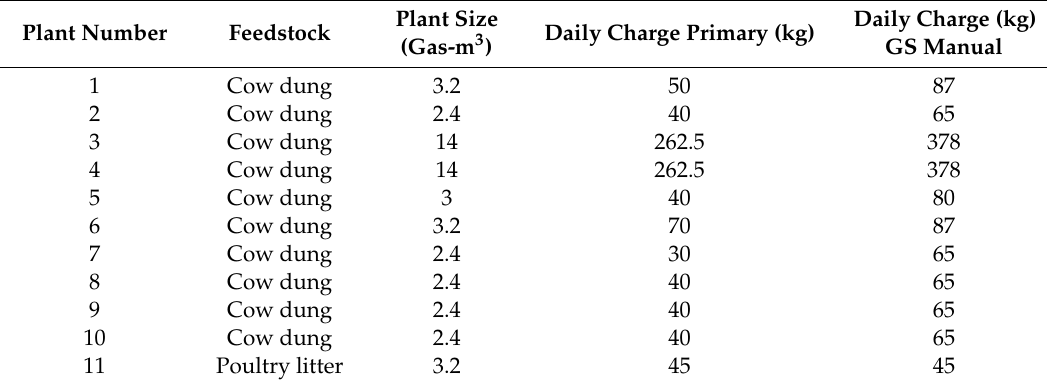
Table 2. An estimate of the daily feedstock supply on-site.